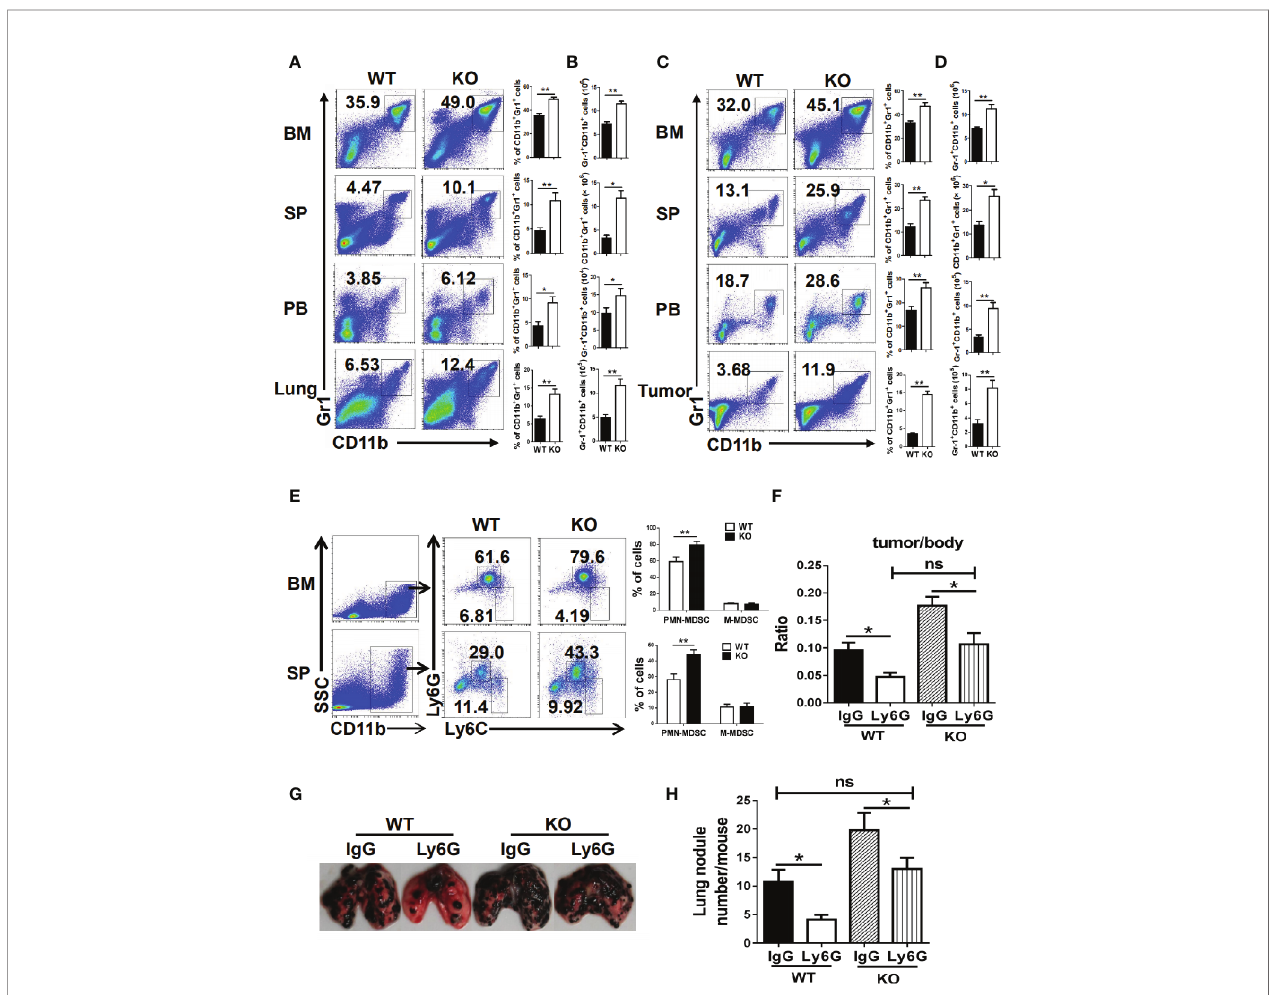
FIGURE 3 | Interferon regulatory factor 4 (IRF4) de fi ciency causes polymorphonuclear myeloid-derived suppressor cells (PMN-MDSCs) elevation in tumor-bearing mice. (A – D) B16-F10 tumor cells were injected into WT or KO mice (n=6) via the tail veil to establish tumor metastasis (A, B) or tumor-growth (C, D) models. Mice were sacri fi ced after 3 weeks. The percentages (A, C) and absolute numbers (B, D) of MDSCs were analyzed by fl ow cytometry; * P < 0.05, ** P < 0.01, Student ’ s t test. (E) The proportions of the MDSCs subtypes in the bone marrow (BM) and spleens from tumor-growth models were evaluated by fl ow cytometry. Each group included six mice; representative results (left) and the graphical representation (right) are shown; ** P < 0.01, Student ’ s t test. (F – H) Mice (n=5) were injected intravenously with anti-Ly6G antibodies or an anti-IgG control before and after B16 tumor cell injection. (F) The ratio of tumor weight to mouse body weight; * P < 0.05, Student ’ s t test. (G, H) Lung transfer was evaluated 3 weeks after tumor injection. (G) Representative images of lung tissue. (H) The number of lung nodules per mouse; ** P < 0.01, Student ’ s t